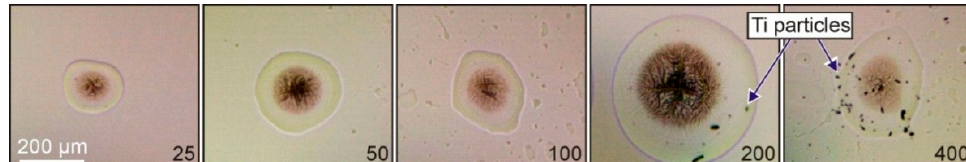
Figure 2. Optical micrographs of dried gel microdroplets on the acceptor slide produced with the same laser irradiation parameters ( τ = 8 ns, E = 20 μ J, and F = 2.8 J/cm 2 ) and different thicknesses of the Ti film on the donor slide. The numbers show the thickness of the Ti film in nanometers. In the last two images, Ti particles both inside and outside microdroplets can be seen.